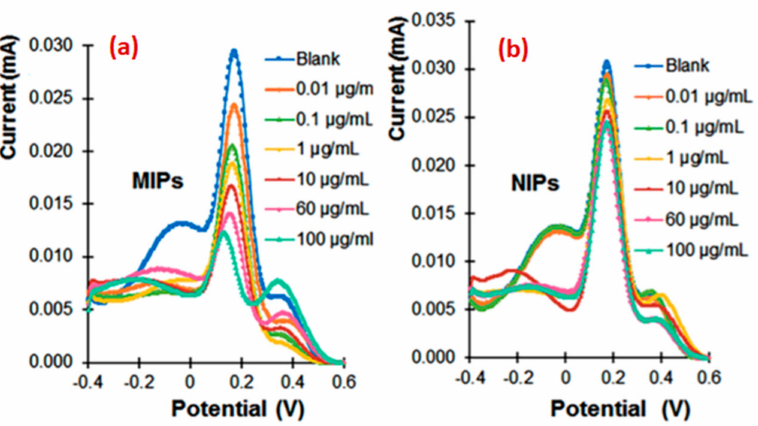
Figure 24. SWV voltammogram: result for MIP with different concentration of flagella (( a ), left) and result for NIP (( b ), right). Reproduced with permission of Elsevier from